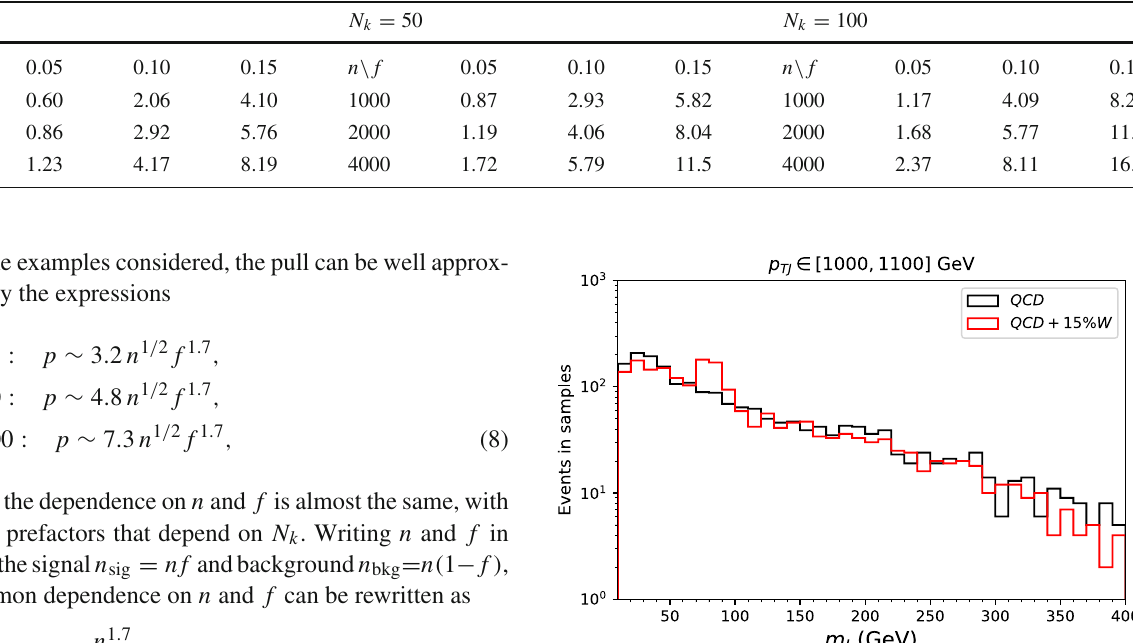
Table 1 Pulls obtained for the comparison of two sets with different values of N k , n and f N k = 25